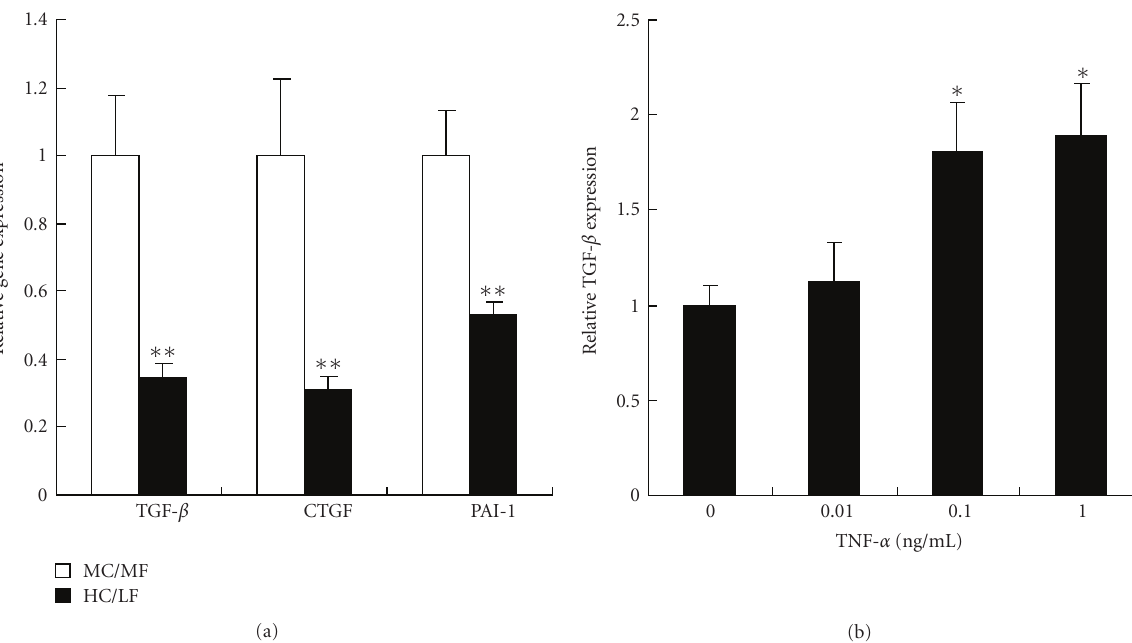
Figure 6: TGF-beta in renal tissues and its induction in vitro by TNF-alpha. (a) Gene expressions of TGF-beta, CTGF, and PAI-1 in MC/MF (white bar) and HC/LF (black bar). ∗ P < . 05, ∗∗ P < . 01. (b) E ff ects of TNF-alpha on TGF-beta mRNA expressions in vitro in cultured rat proximal tubular cells (IRPTC). ∗ P < . 05, ∗∗ P < .